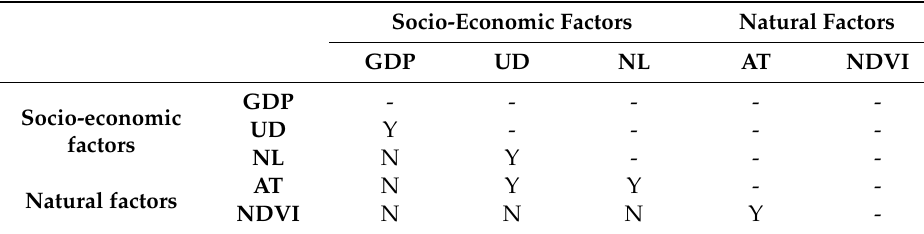
Table 3. The result of an ecological